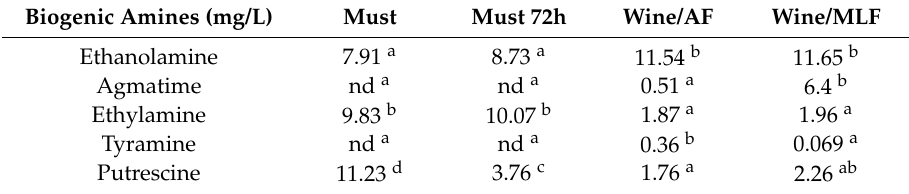
Table 2. Individual biogenic amines during winemaking (from Del Prete et al. [58]). Biogenic Amines (mg/L) Must Must 72h